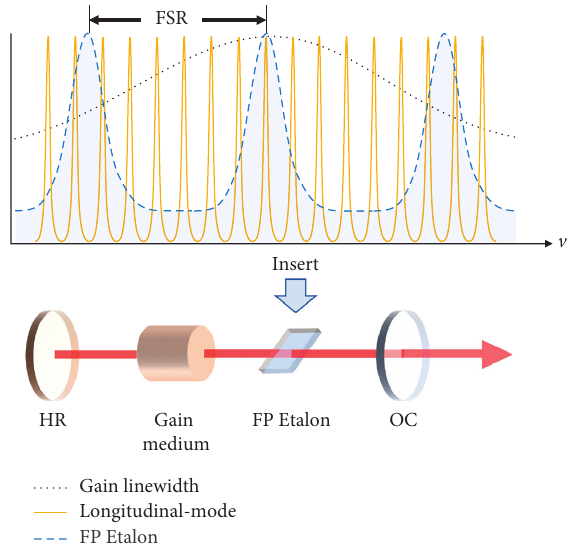
Figure 4: Schematic of SLM selection by Fabry–Perot